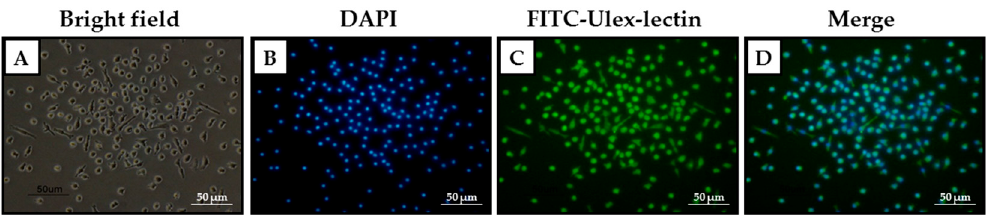
Figure 3. Staining of late EPCs obtained from a representative MA patient by ( A ) Bright field and ( B – D ) fluorescence microscopy; ( B ) DAPI, ( C ) FITC-Ulex-lectin, ( D ) DAPI+FITC-Ulex-lectin (20× magnification, 50 µm scale bar).